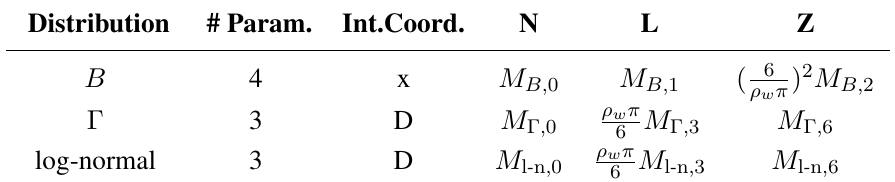
, bulk density of water. w